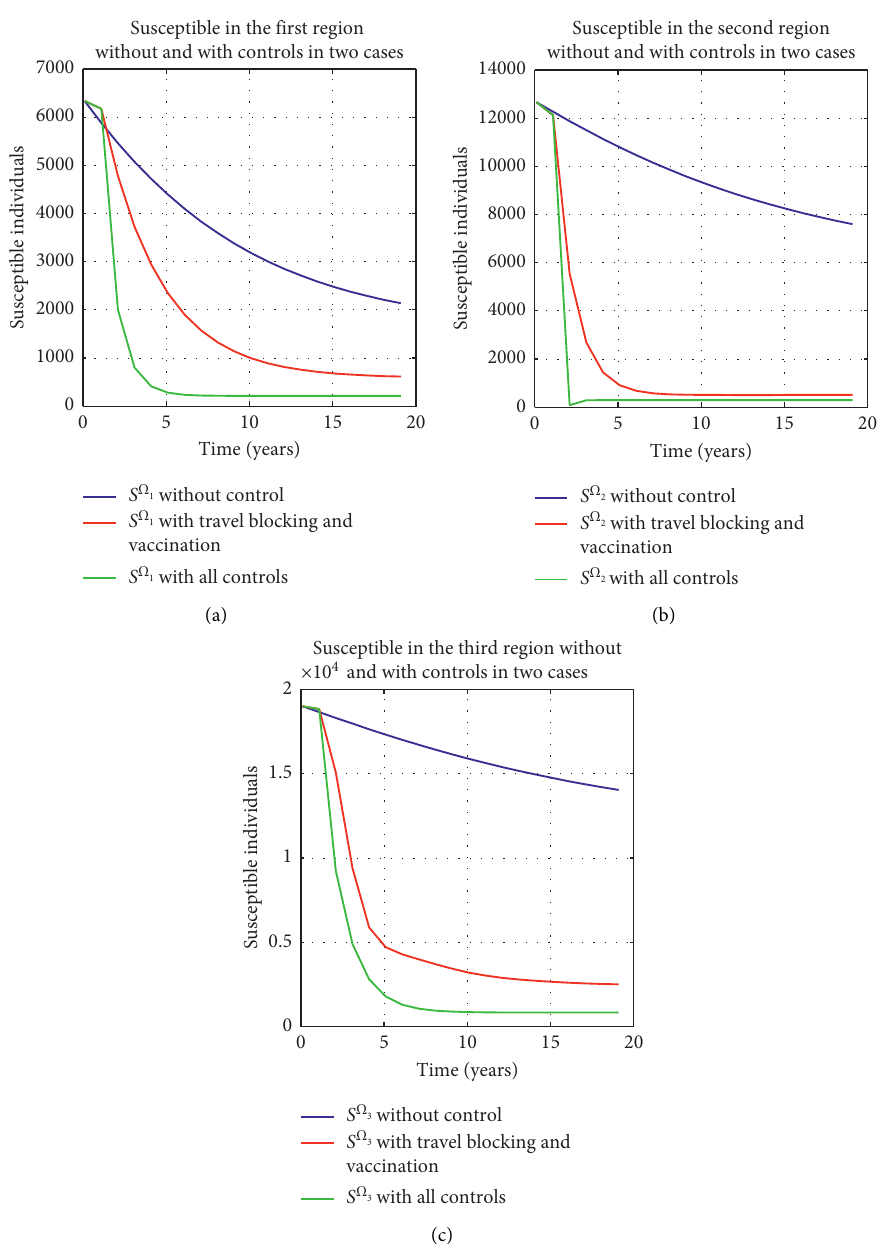
Figure 9: Comparison of the susceptible in each region without control and with control in two